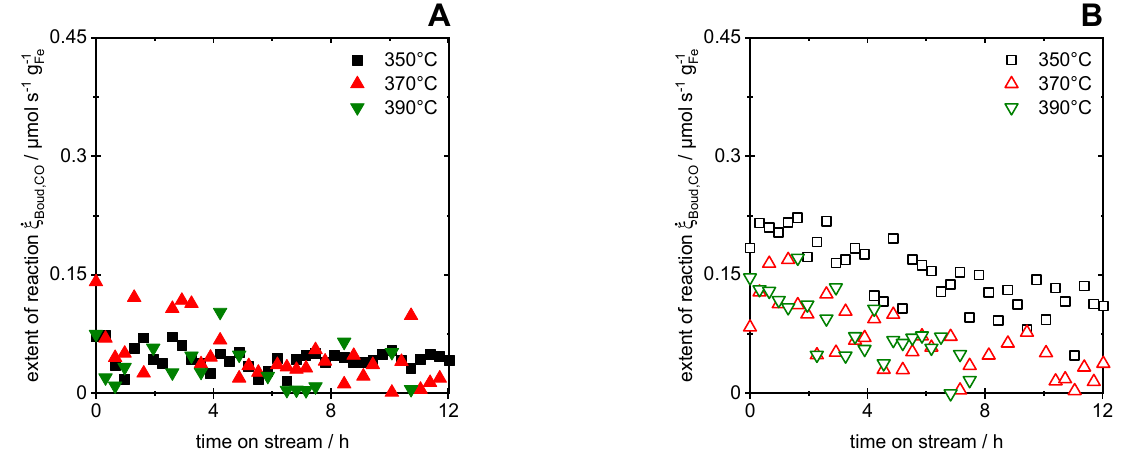
Figure 4. Extent of Boudouard reaction ξ Boud as function of time-on-stream at 350, 370 and 390 ◦ C during CO hydrogenation before (( A ), filled symbols) and after (( B ), empty symbols) CO 2 treatment. Furthermore, after the evaluation of the experimental data according to Equation (16), the extent of CO hydrogenation was obtained. Hence, Figure 5 shows the extent of CO hydrogenation ξ CO during 12 h TOS for the reaction temperatures of 350, 370 and 390 °C, respectively. The filled symbols represent the catalytic results before, while the empty symbols represent those after the CO 2 treatment. The time-resolved course before CO 2 treatment (see Figure 5A) exhibited a slow but monotone increase in reaction extent at 350 °C and a rather constant profile at 370 and 390 °C. Furthermore, a slight temperature dependence was observed for both before (Figure 5A) and after (Figure 5B) CO 2 treatment. Therefore, we estimated apparent activation energies of 59 ± 19 kJ/mol before and 68 ± 24 kJ/mol after CO 2 treatment, calculated from the values at ca. 8 h TOS, respectively. The calculated values are in good agreement with the literature [65], though the high values for the standard deviation resulted from the scattering of the data. The corresponding Arrhenius plots are shown in SI (see Supplementary Materials, Figure S5C).